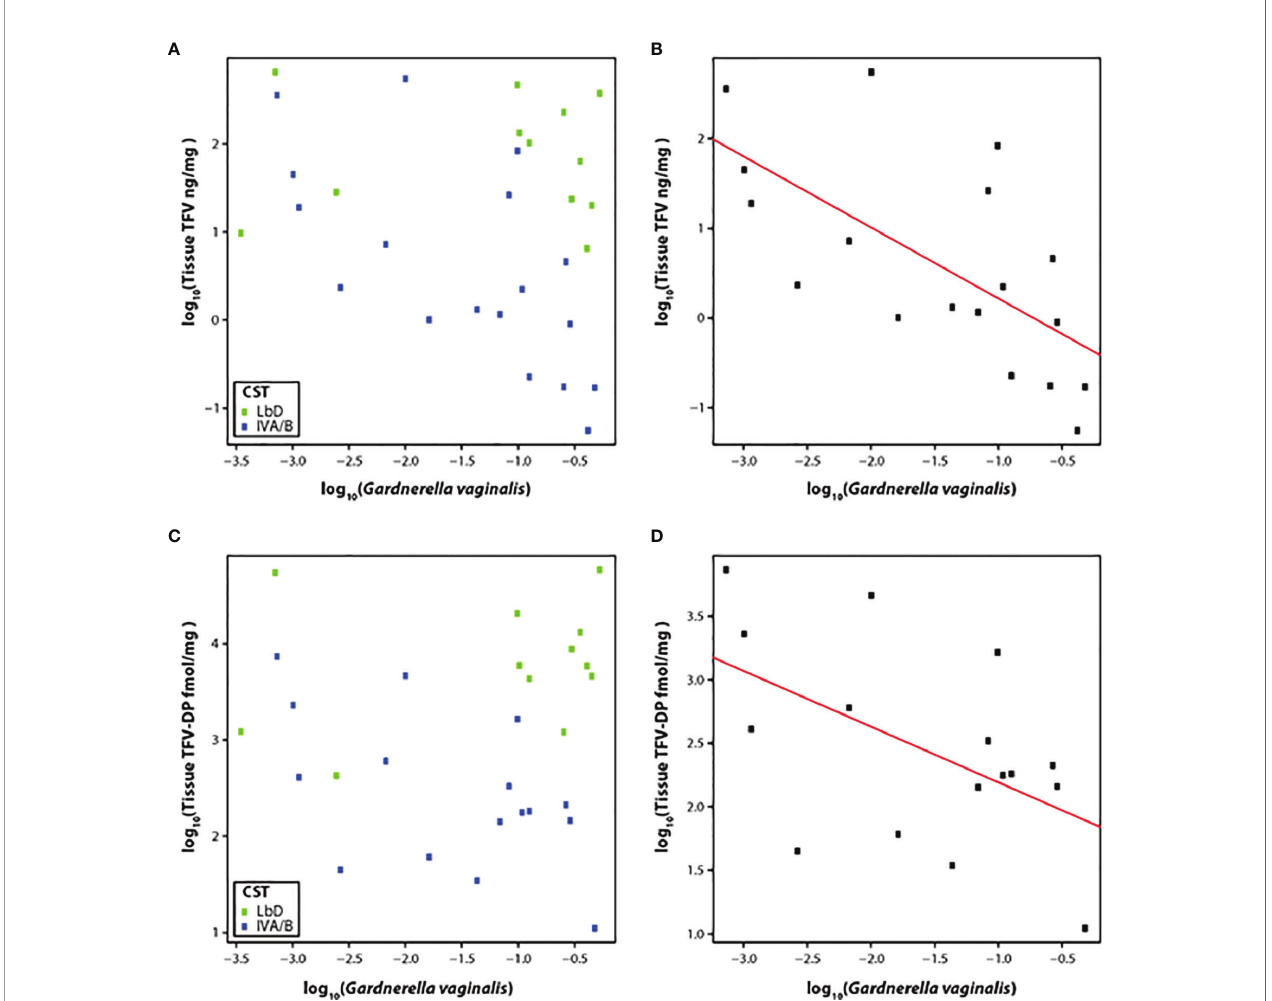
FIGURE 3 | (A – D) Correlation of TFV (A) and TFV-DP (C) tissue concentrations with relative abundance of G. vaginalis species and fi t of the linear model with CST IV samples at the end of treatment with TFV tissue concentrations (B) and TFV-DP tissue concentrations (D) . Green dots represent participants who had Lactobacillus-dominated (LbD) vaginal microbiota at the time of sampling and their individual TFV vaginal fl uid concentration and relative abundance of Gardnerella vaginalis . Blue dots represent participants who had diverse anaerobe-dominated (CST IVA/B) vaginal microbiota at the time of sampling and their individual TFV vaginal fl uid concentration and relative abundance of Gardnerella vaginalis . Black dots in the linear fi t model represent participants who had diverse anaerobe- dominated (CST IVA/B) vaginal microbiota at the time of sampling and their individual TFV vaginal fl uid concentration and relative abundance of Gardnerella vaginalis